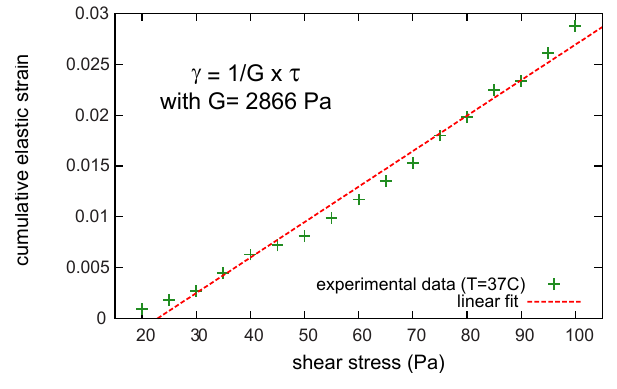
Fig. 3. Strain-stress curve obtained using the shear strain augmenta- tion synchronous with the shear stress growth prior to reaching the plastic yield